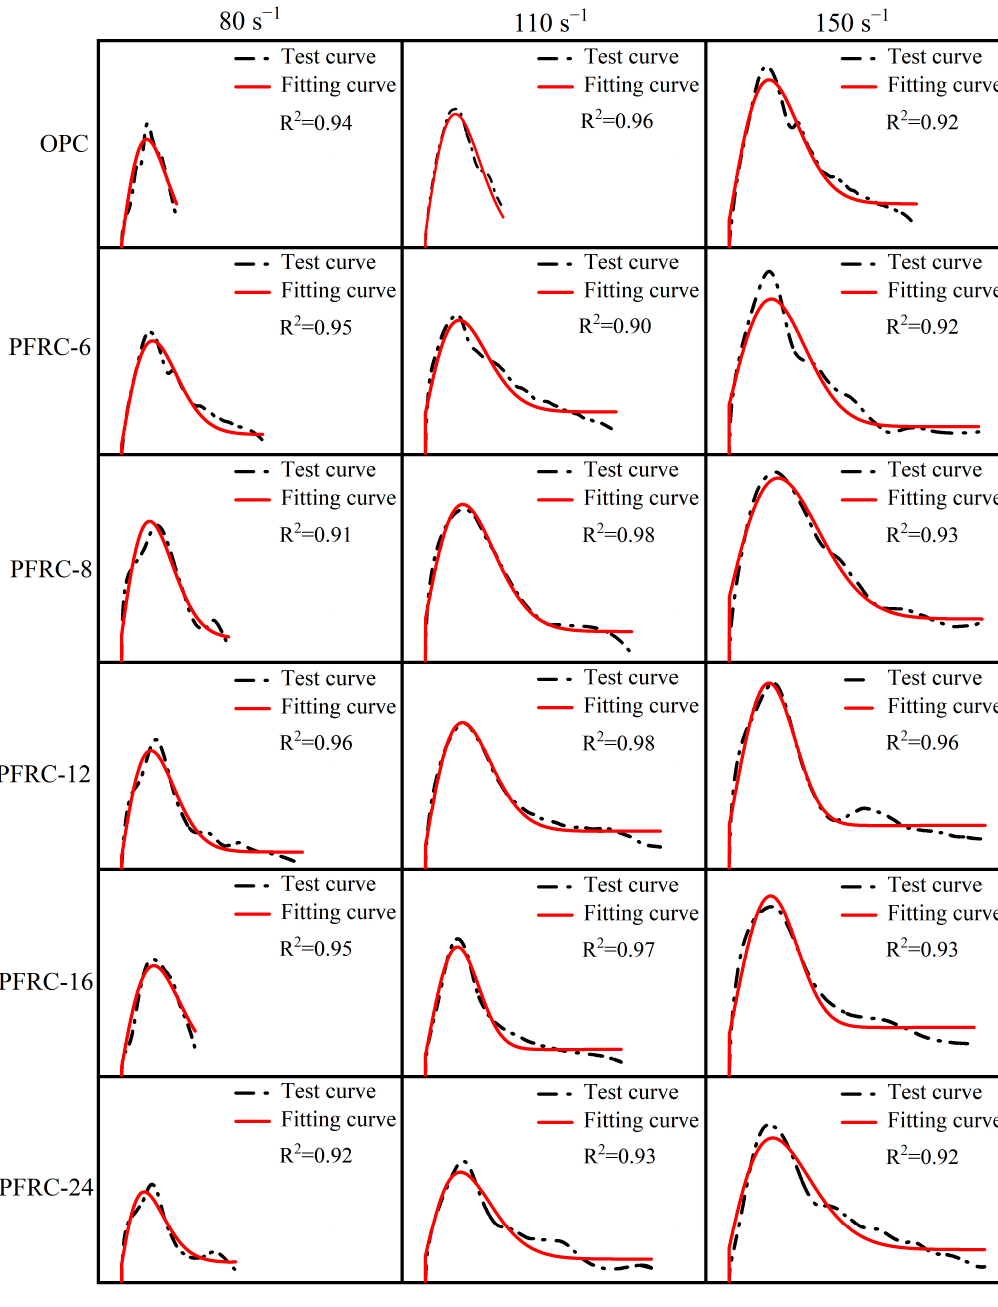
Figure 16. Comparison of experimental and fitted stress–strain curves of specimens at different strain